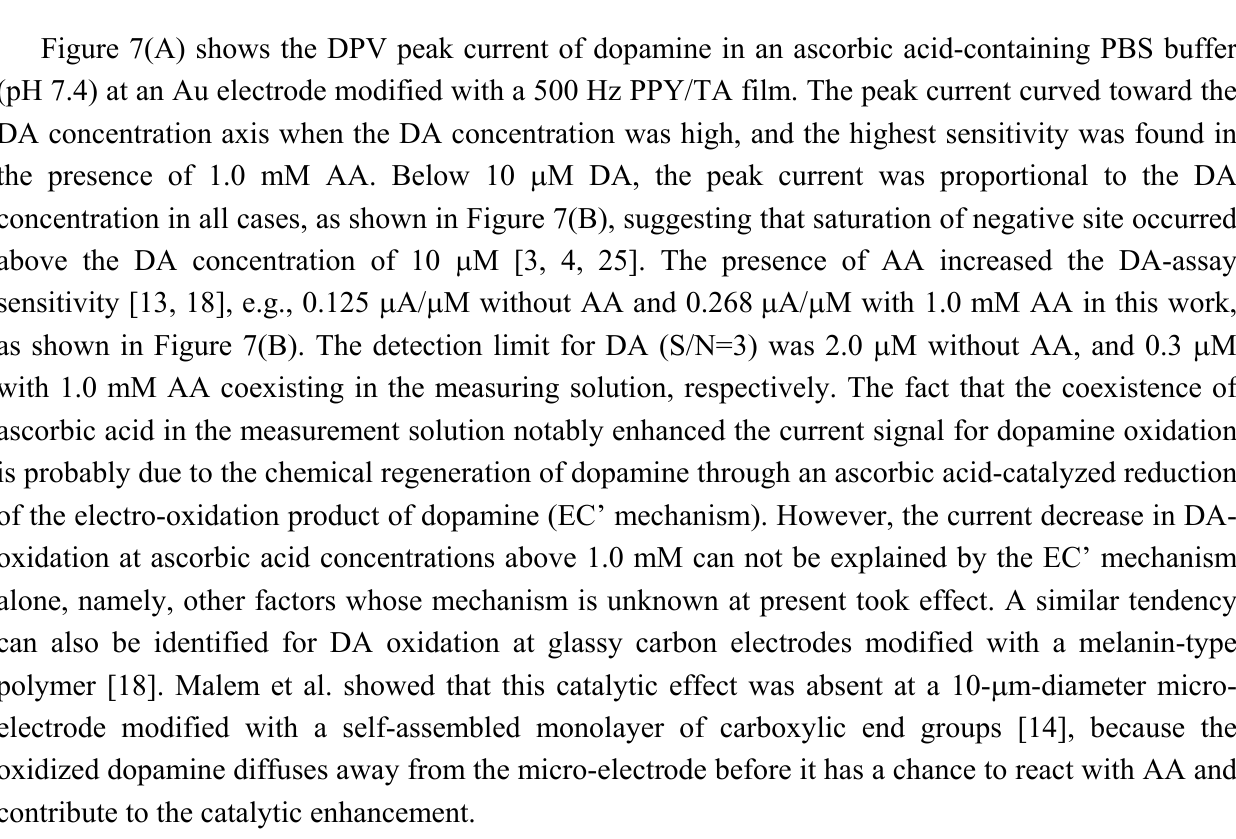
Figure 6 . DPV peak current for ascorbic acid oxidation in PBS buffer (pH 7.4) at an Au electrode modified with a 500 Hz PPY/TA